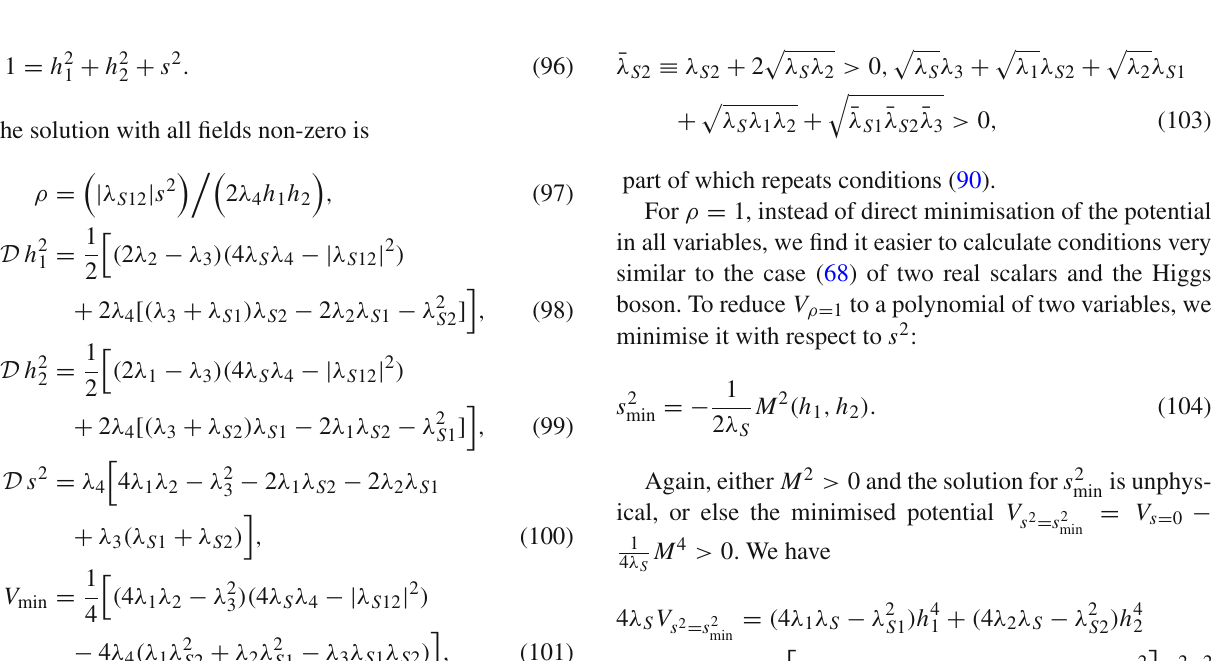
Fig. 4 The allowed parameter space for some values of the couplings of the 2HDM. For all panels λ 2 = 0 . 25, λ 4 = 0 . 25, λ 5 = 0. The values of other parameters are λ 1 = 0 . 125, λ 3 = 0 for the first panel ,